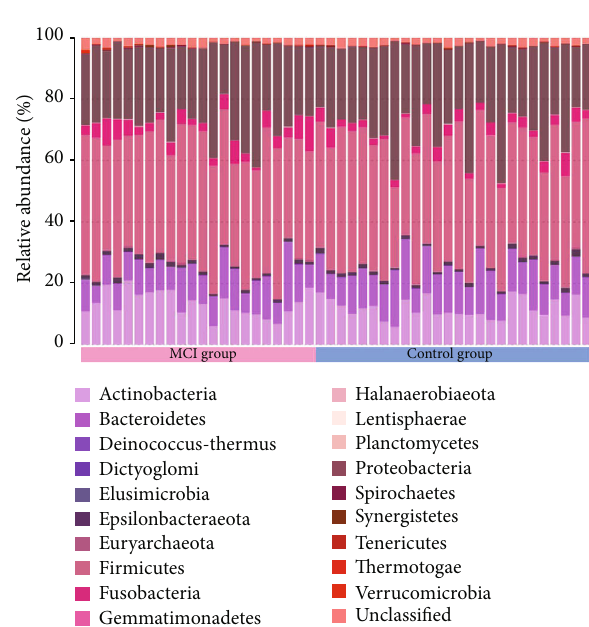
Figure 1: Gut microbiota composition. Proportion of the di ff erent phyla (represented by di ff erent colors) detected in the two